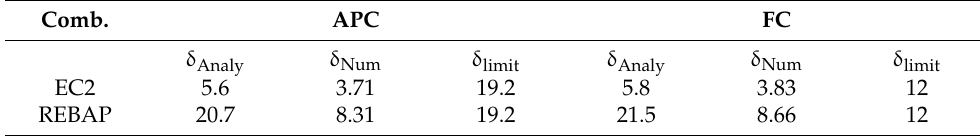
Table 11. Deformation and limit values of the 2NLM for the second case of study (values in mm). Comb.